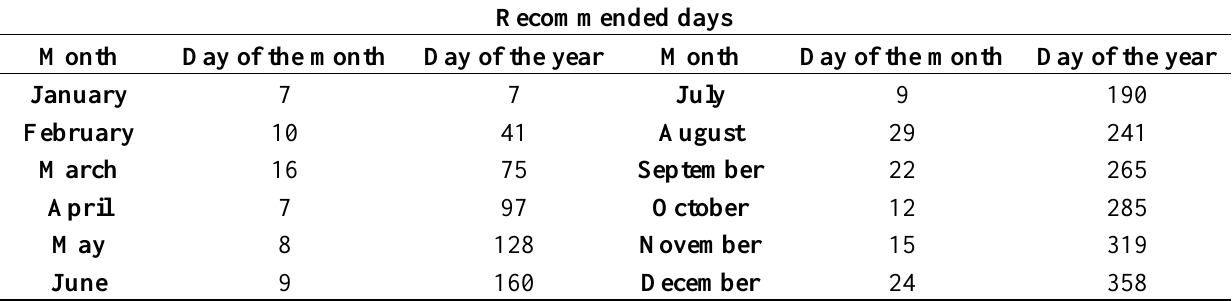
Table 2. Recommended days for each month of the year for the city of Poznan (own calculations). Recommended